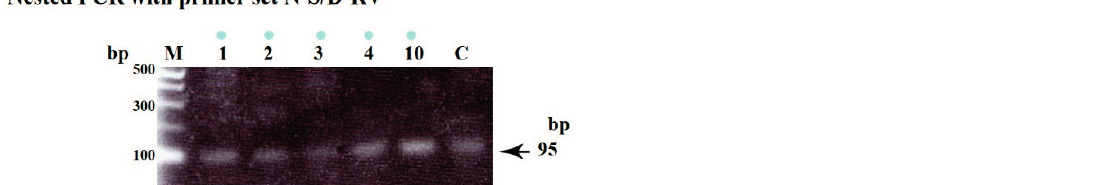
Figure 3. Upper panel . Production of ~350 bp products after first and nested PCR of genomic DNA initially amplified using WGA from a single blastocyst. Lanes 1 – 17 correspond to single numbered blastocysts (a part of these blastocysts is shown in Figure 2). The symbols above each lane indicate the fluorescence distribution type (ubiquitous (u) or mosaic (m)) and its strength (strong (++), moderate (+), slight (+/ − ), or none ( − )); Middle panel : A T7E1-based assay for each single blastocyst. The approximately 350 bp PCR products shown in the upper panel were mixed with control (C) DNA at a ratio of 1:1, denatured, re-annealed, and then incubated with the T7E1 enzyme for 1 h at 37 °C. The resulting products were then electrophoresed in a 2% agarose gel. If samples have indel mutations, two fragments, namely ~200 and ~150 bp, were generated as cleaved products of the original ~350 bp products. The blue dots above the lanes indicate samples with mutations. Arrowheads indicate the position of cleaved bands, namely ~200 and 150 bp bands. Lanes 1 – 17 correspond to single numbered blastocysts as shown in the upper panel (except blastocyst number 13, which DNA amplification failed). Lane C indicates genomic DNA from normal PEFs used as a negative control; Lower panel : Production of 95 bp products after nested PCR of the first PCR products shown in the upper panel using primer sets N-S and D-RV (see Figure S1 and Table S1). Lanes 1 – 4 and 10 (all of which were identified as having mutations) correspond to single numbered blastocysts as shown in the upper and middle panels. Lane C indicates genomic DNA from normal porcine embryonic fibroblasts (PEFs) used as a positive control. M , 100 bp ladder